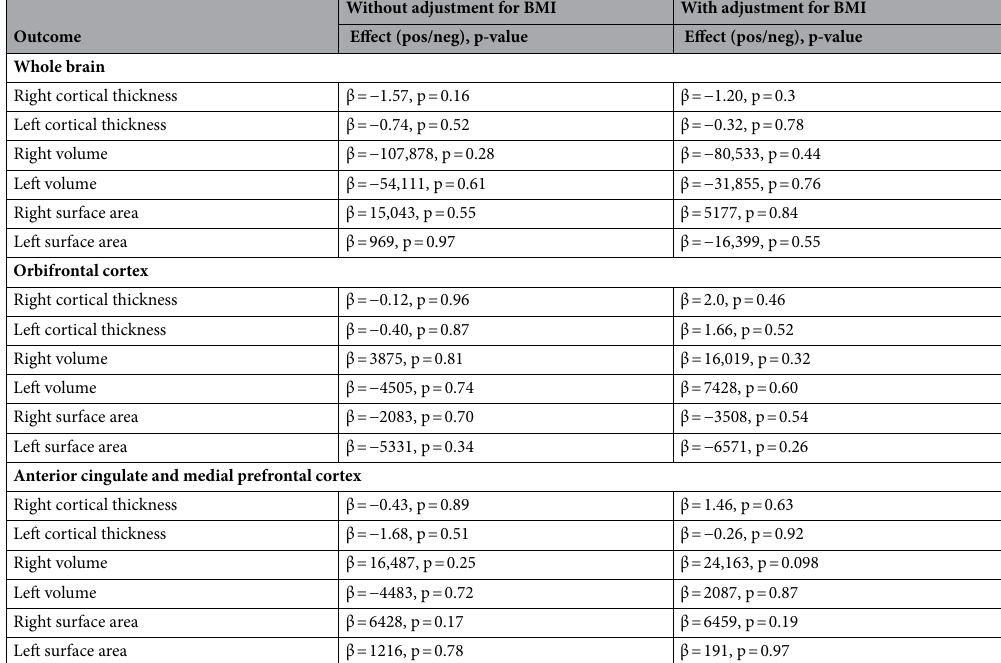
Table 4. Results for longitudinal effects of the genetic score for BMI on brain parameters at SHIP-3 with and without additional adjustment for BMI. Analyses are adjusted for ICV, age_2, sex, age*sex interaction, brain parameter at SHIP-2 and follow-up time, volume refers to